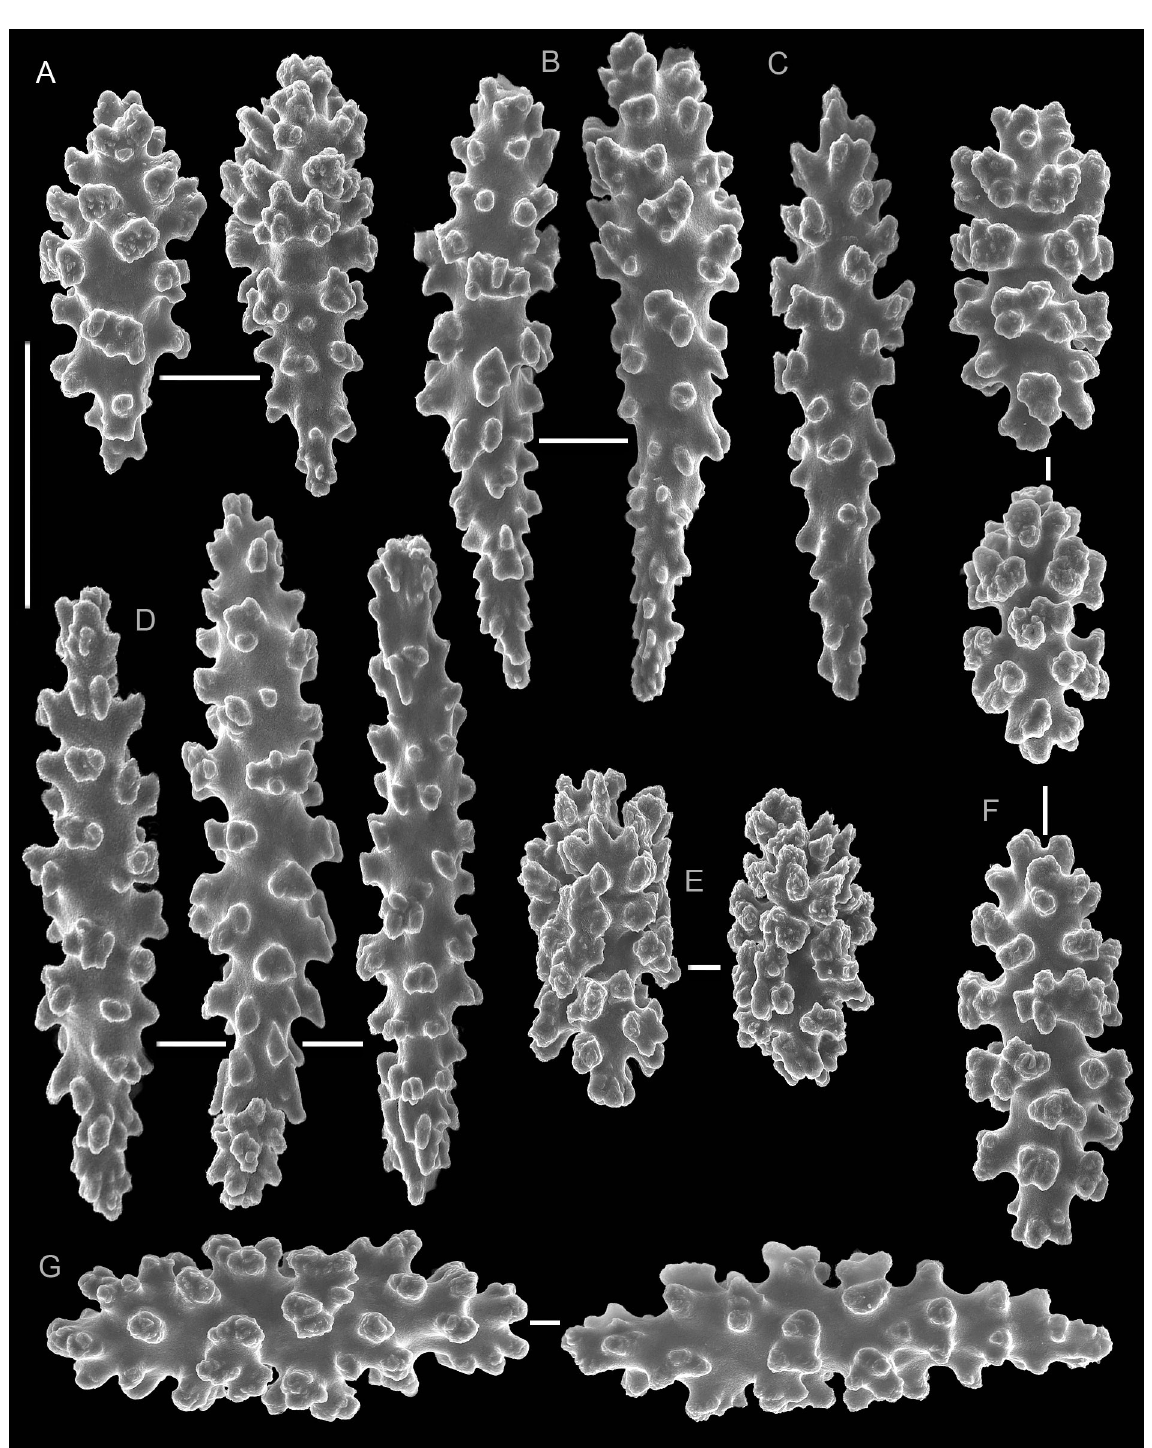
Fig. 9. Calcigorgia simushiri sp. nov., holotype (MIMB 20721), sclerites from the lower part of the polyp body wall. A . Densely ornamented short clubs. B . Longer clubs with slightly curved handles. C . Club- like spindle. D . Spindles densely ornamented with inclined conical hillocks. E . Ovals. F . Capstans ornamented with girdled warts. G . Thick spindles covered by warts tending to be girdled. Scale bar: 0.1